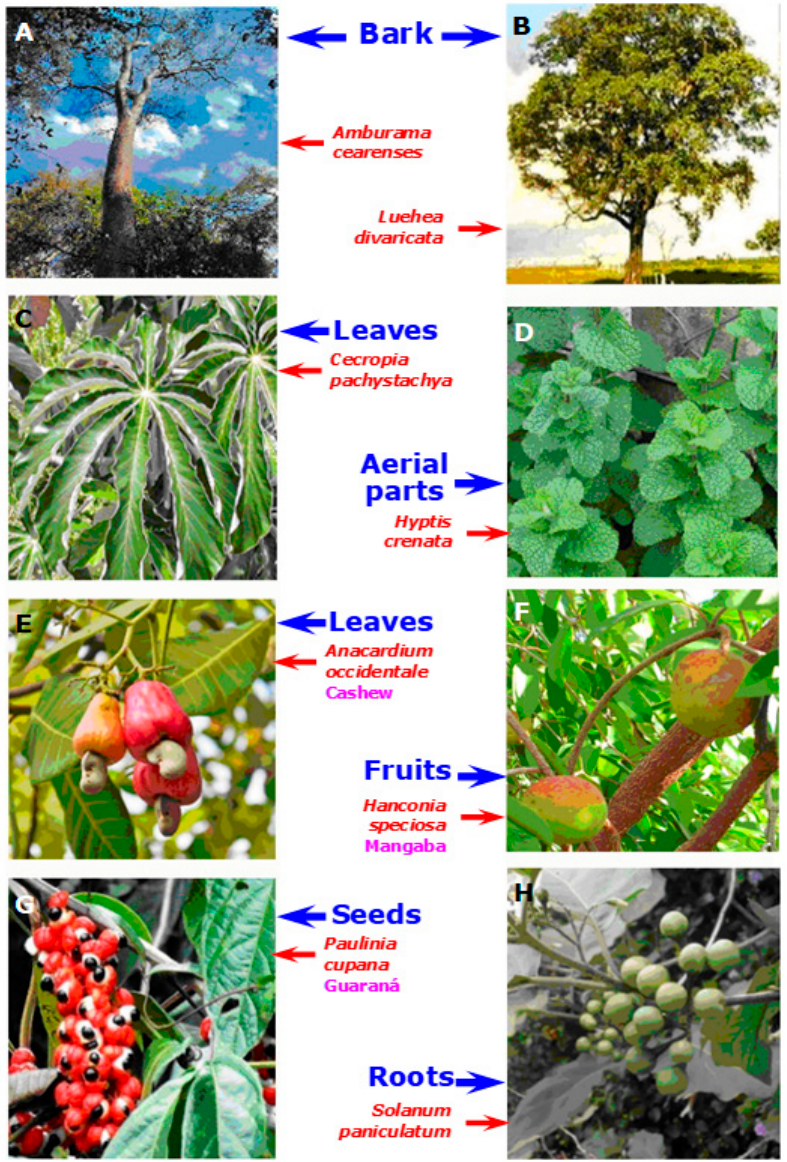
Figure 3. A selected group of the hepatoprotective plants described in the text and in Table 1, highlighting the parts from which the active extracts were prepared.